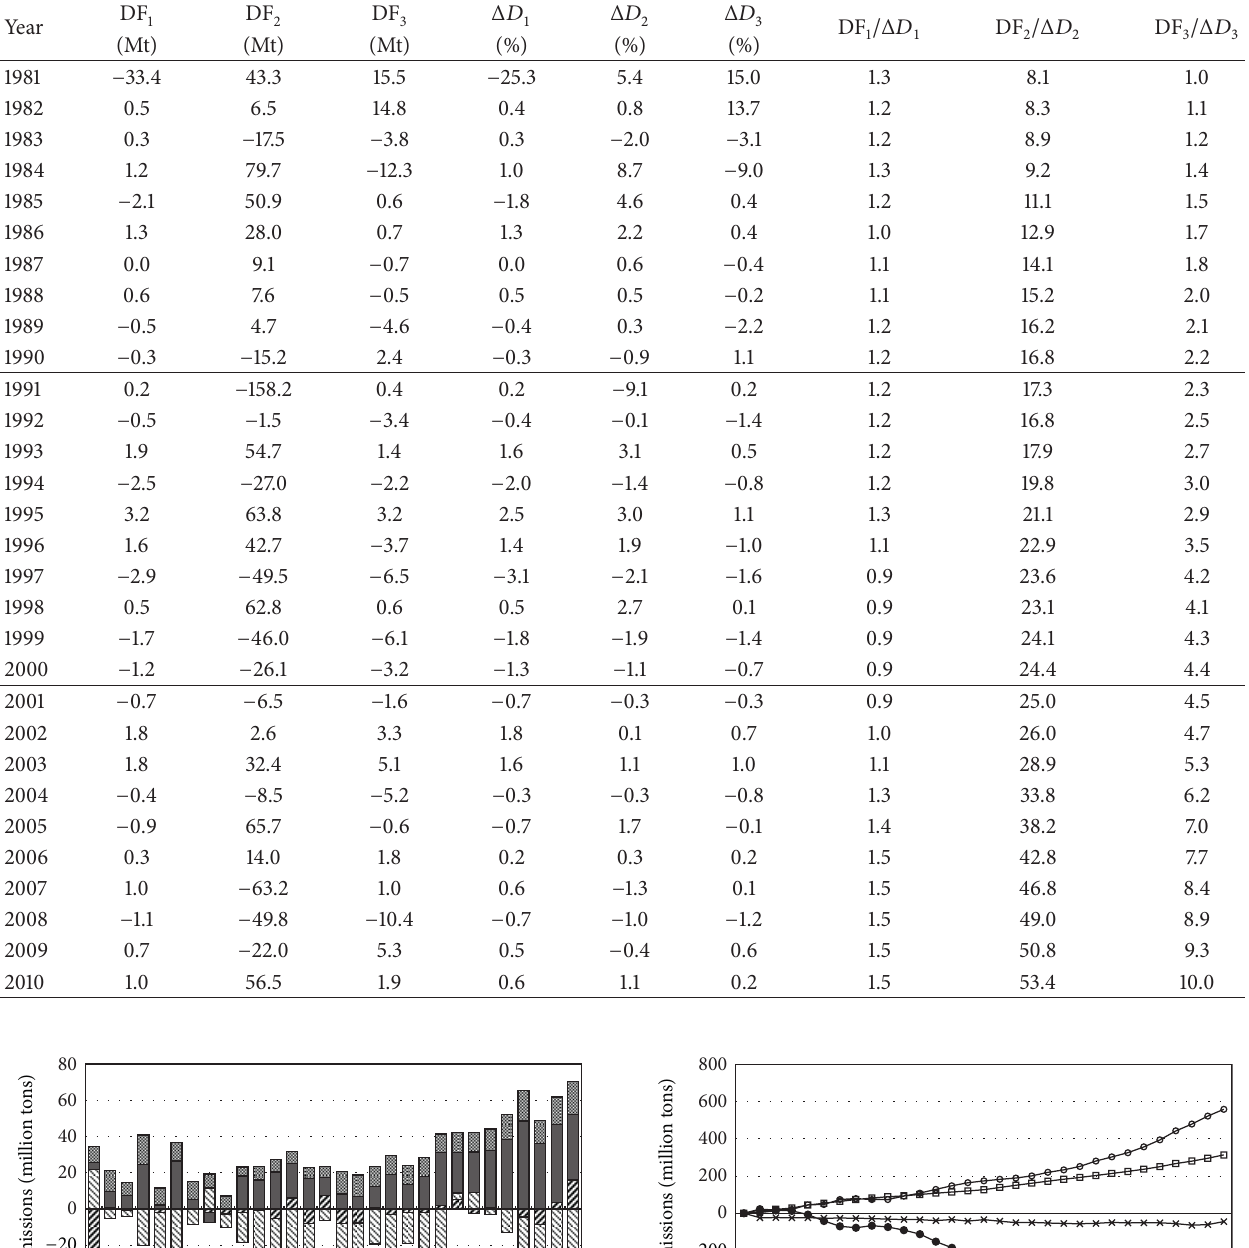
Table 8: Decomposition results of emission factor (1981–2010).